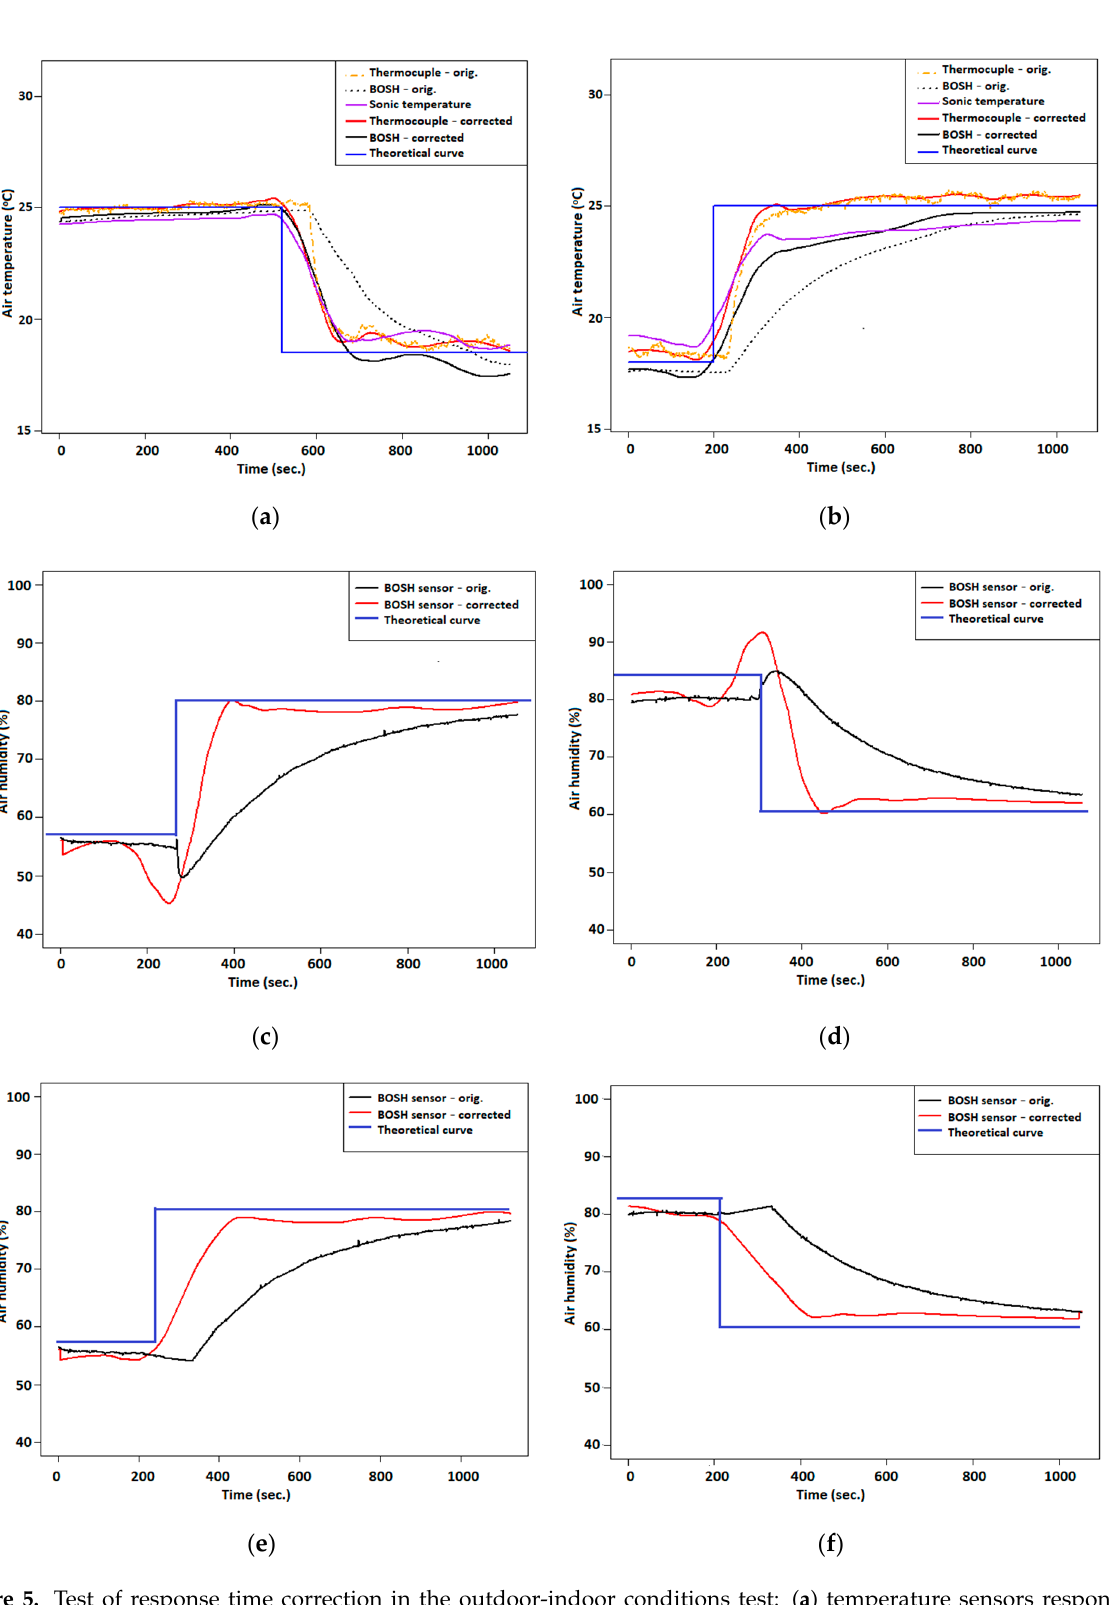
Figure 5. Test of response time correction in the outdoor-indoor conditions test: ( a ) temperature sensors response—cooling; ( b ) temperature sensors response—heating; ( c ) air humidity sensor response—moistening; ( d ) air humidity sensor response—drying; ( e ) air humidity sensor response—moistening (with data overshoot correction); ( f ) air humidity sensor response—drying (with data overshoot correction).